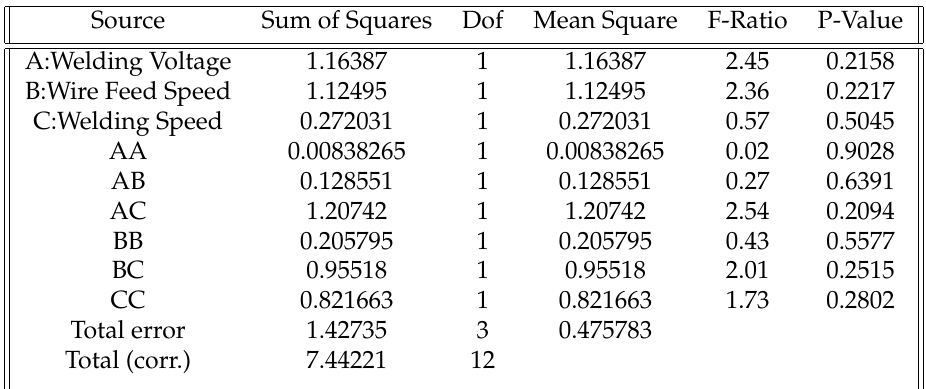
Table 6. Variance’s analysis for SQRT of Deposition